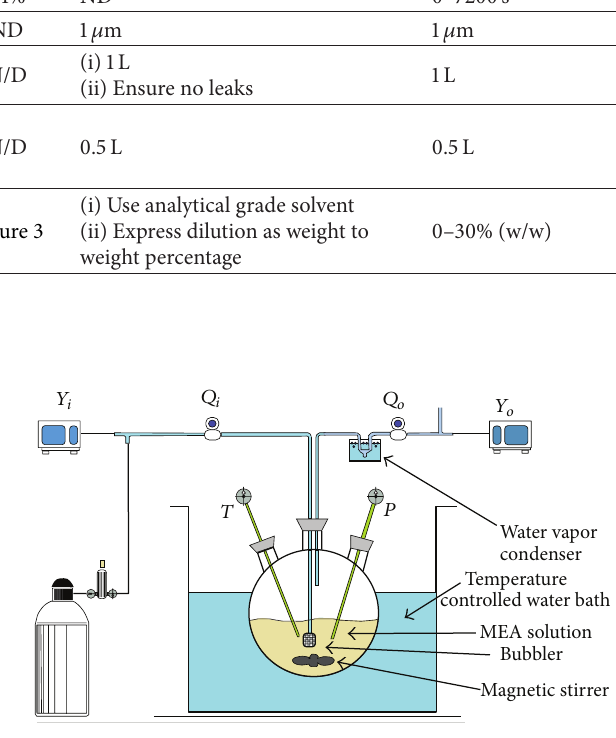
Figure 2: Proposed apparatus to determine the absorbing capacity of gas phase components by liquid phase absorbers.